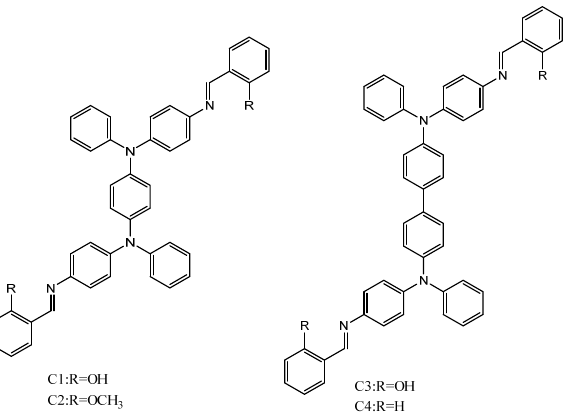
Figure 20. Structural representation of the molecules for detection of hydrazine in live cells.